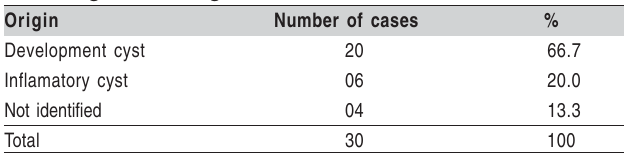
Table 3 - Distribution of cases of odontogenic cysts according to the origin. São Luís,